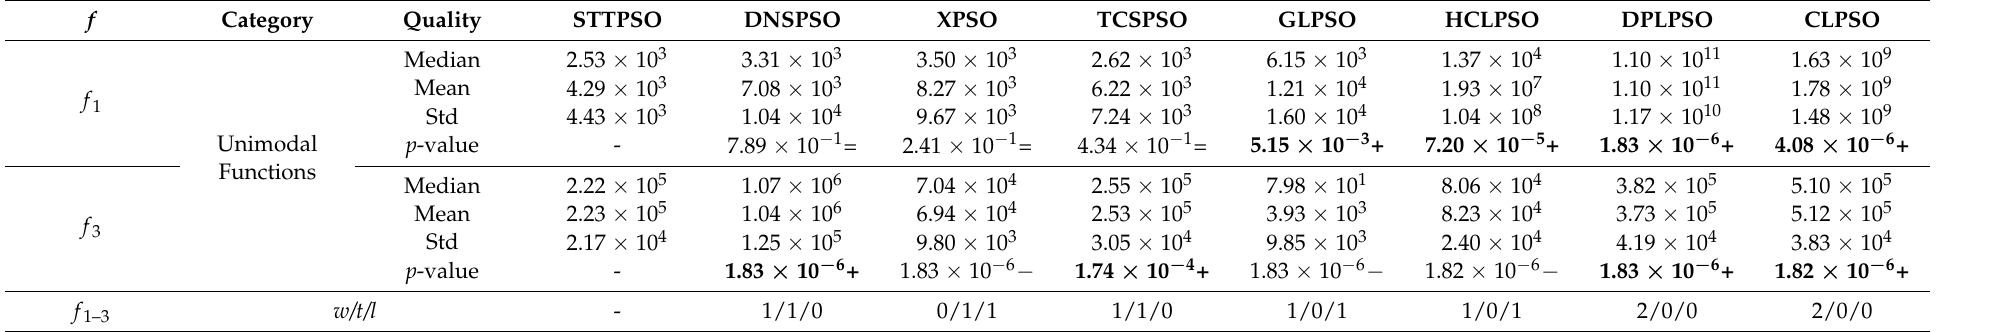
Table 5. Comparison results between the proposed STTPSO and the 7 state-of-the-art and popular PSO variants on the 100 D CEC 2017 benchmark functions. The highlighted p -values means that the proposed STTPSO is significantly better than the associated compared algorithms on the corresponding